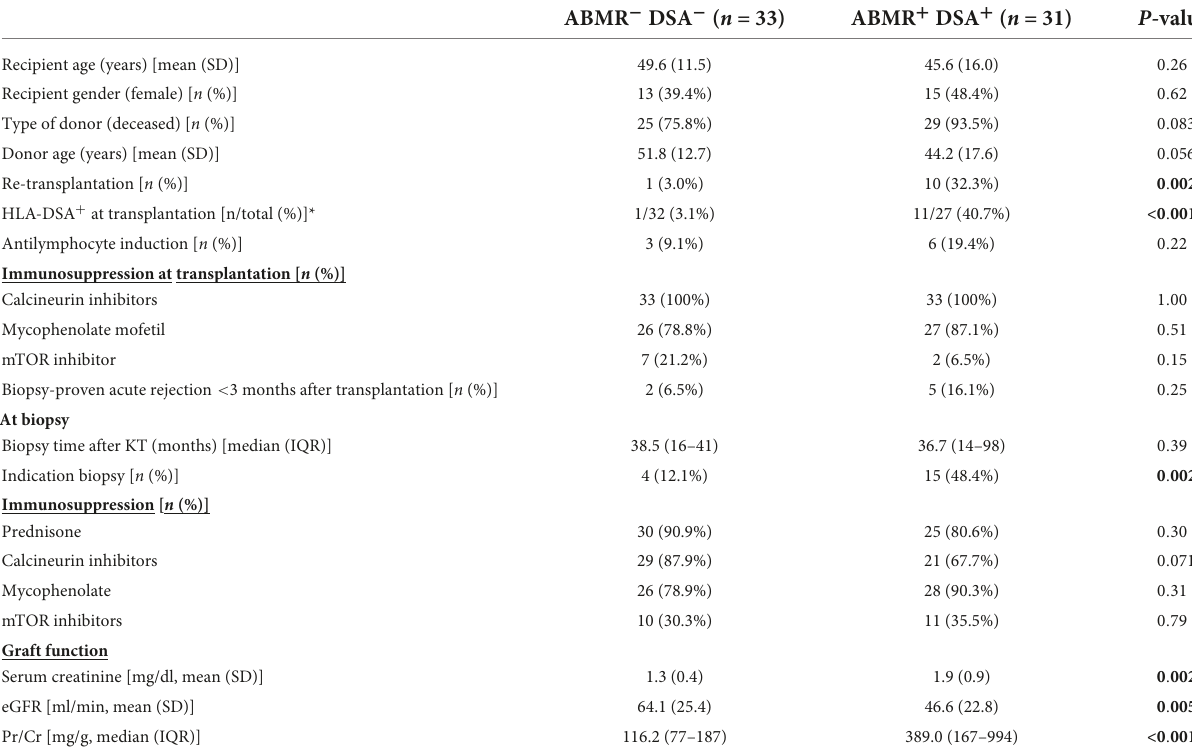
TABLE 1 Main demographic and clinical characteristics of patients with ABMR and HLA-DSA (ABMR + DSA + ) and without ABMR and HLA-DSA (ABMR − DSA − ).